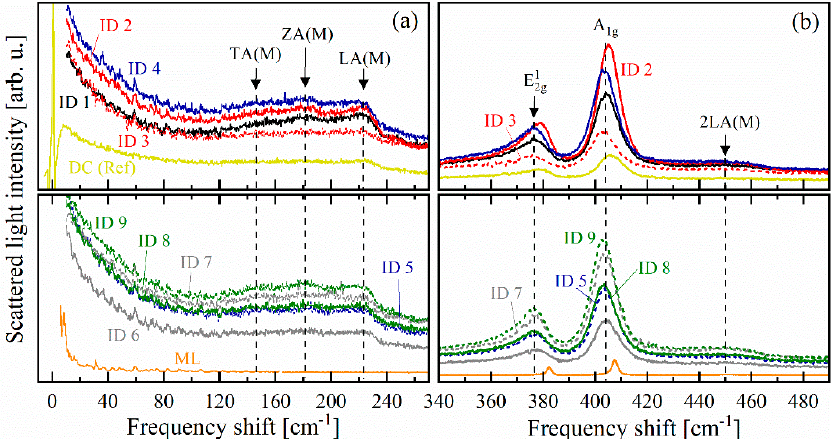
Figure 6. Inelastic light scattering spectra of the MoS x films and a mechanically exfoliated MoS 2 monolayer (ML). In ( a ) the acoustic phonon modes at about 180 cm − 1 and in ( b ) the optical phonon modes at about 390 cm − 1 are depicted. The laser line at 0 cm − 1 is shown exemplarily in the spectrum of the DC sputtered film. These Stokes scattered lines were collected with an integration time of 100 s. Each film was studied at three different surface positions. The spectrum of the monolayer (ML) is multiplied by 1/100.